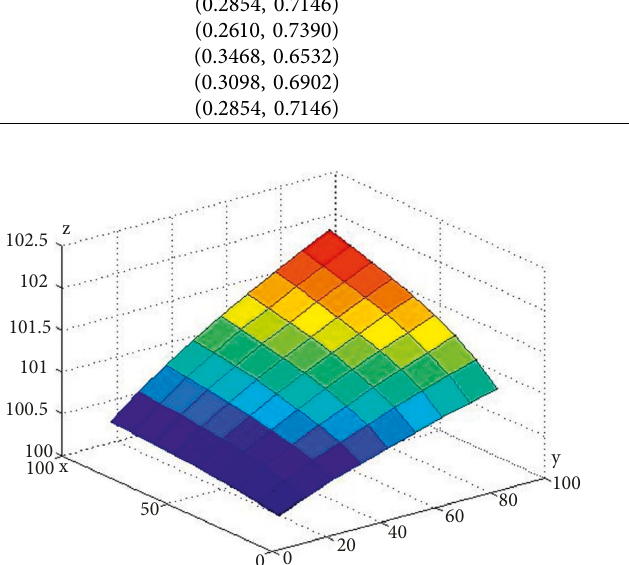
and L . In this figure, x axis denotes the losses caused by invasion to the data ( L 1 2 ), and z axis denotes expected loss of smart 2